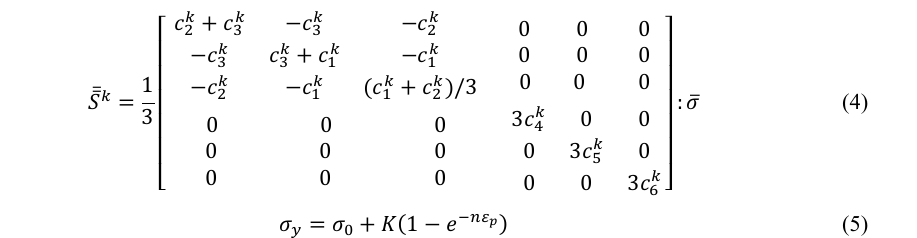
Table 1. Identified material parameters for the AA2198-T351